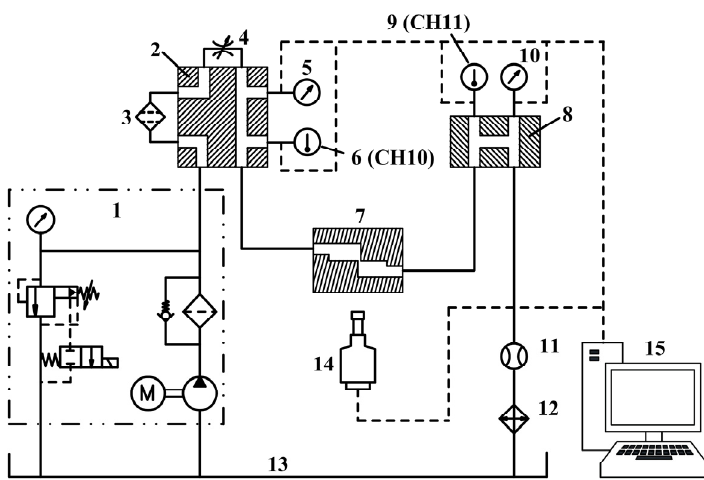
Figure 4. Hydraulic system used in the experiment: 1—hydraulic pumping station; 2—inlet integration block; 3—oil filter; 4—throttle valve; 5—inlet pressure sensor; 6—inlet thermometer; 7—experimental device; 8—outlet integration block; 9—outlet thermometer; 10—outlet pressure sensor; 11—flowmeter; 12—radiator; 13—hydraulic tank; 14—microscope; 15—data recorder.